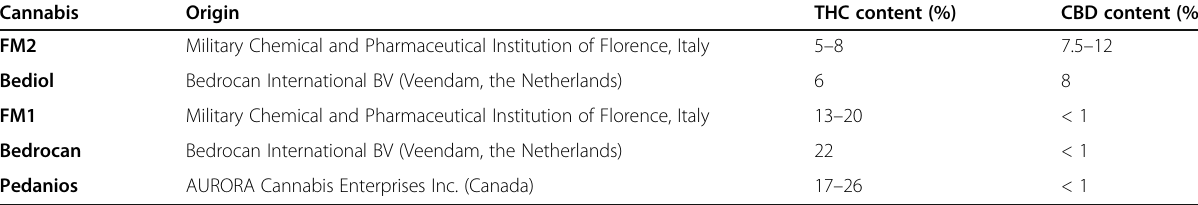
Table 1 Medical cannabis cultivars prescribed to 38 patients with fibromyalgia syndrome at an Italian pain clinic